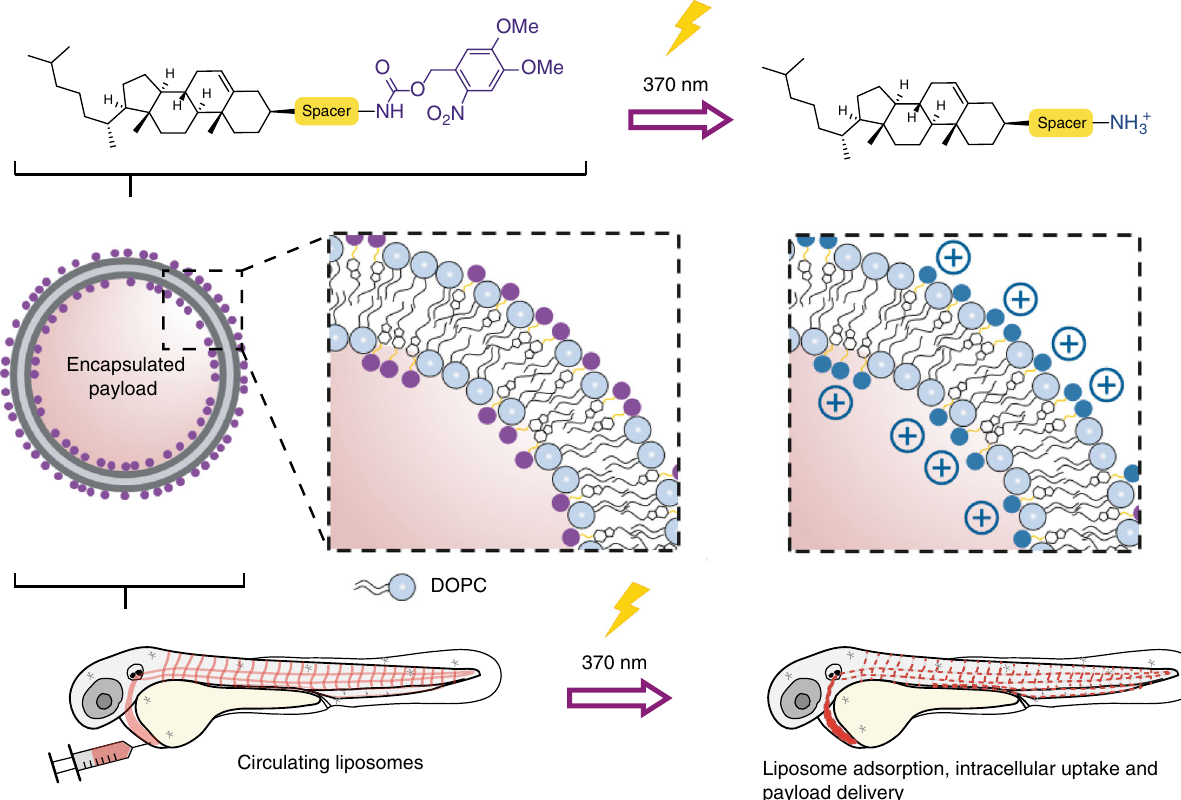
Fig. 1 Photoswitching the surface charge of a liposome – from neutral to cationic – requires photoactive lipids embedded within a liposome membrane. Prior to light activation, charge neutral, photoactive liposomes freely circulate throughout the vasculature of a zebra fi sh embryo and do not interact with RES cell types, or any other cell type, of the embryonic fi sh. Upon light irradiation and photolysis of photocaged, cholesterylamine lipids, rapid surface charge switching, from neutral to cationic, leads to non-speci fi c adsorption of liposomes across the endothelium of the embryo, liposome uptake and intracellular delivery of liposome-encapsulated, membrane impermeable payloads. DOPC 1,2-dioleoyl- sn